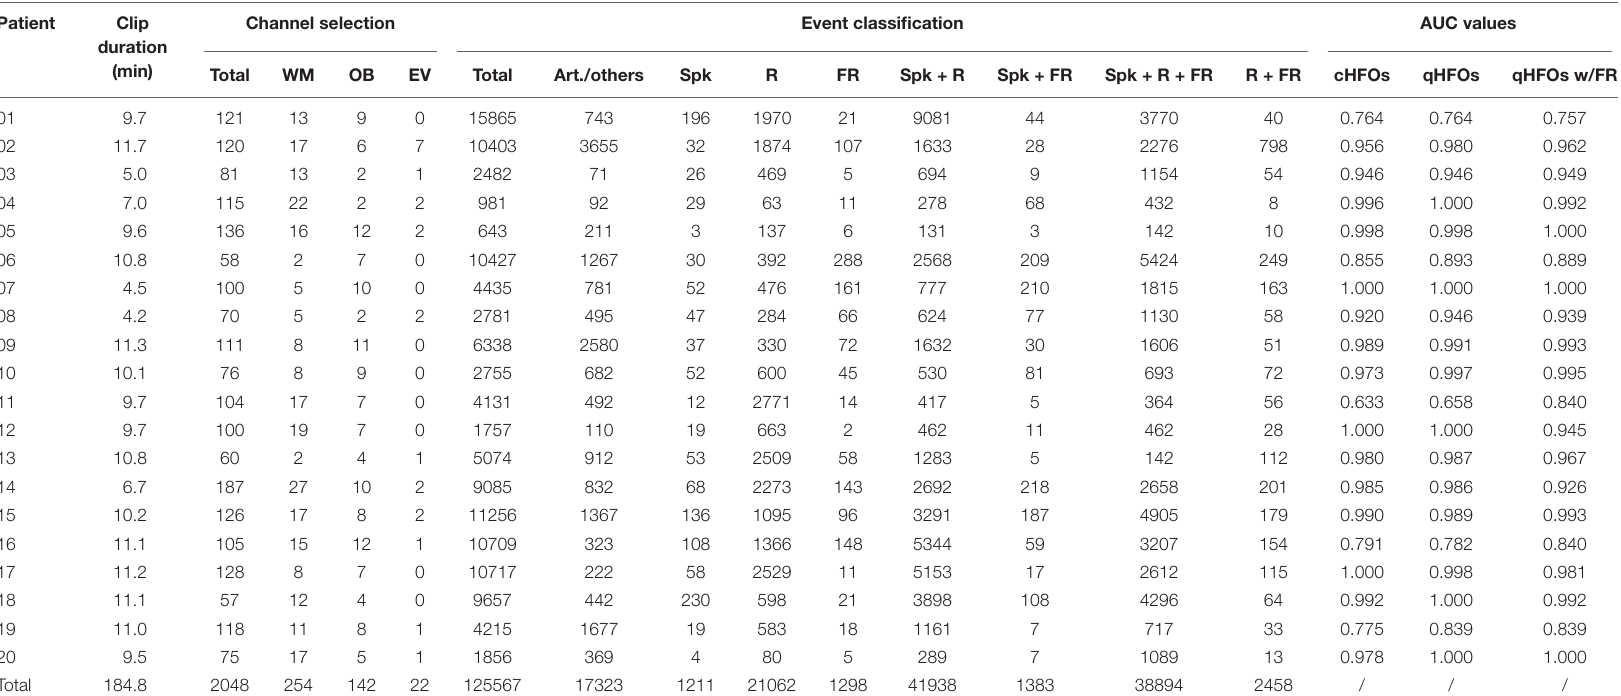
TABLE 2 | Detection and classification results and the AUC values regarding SOZ of 20 testing patients.